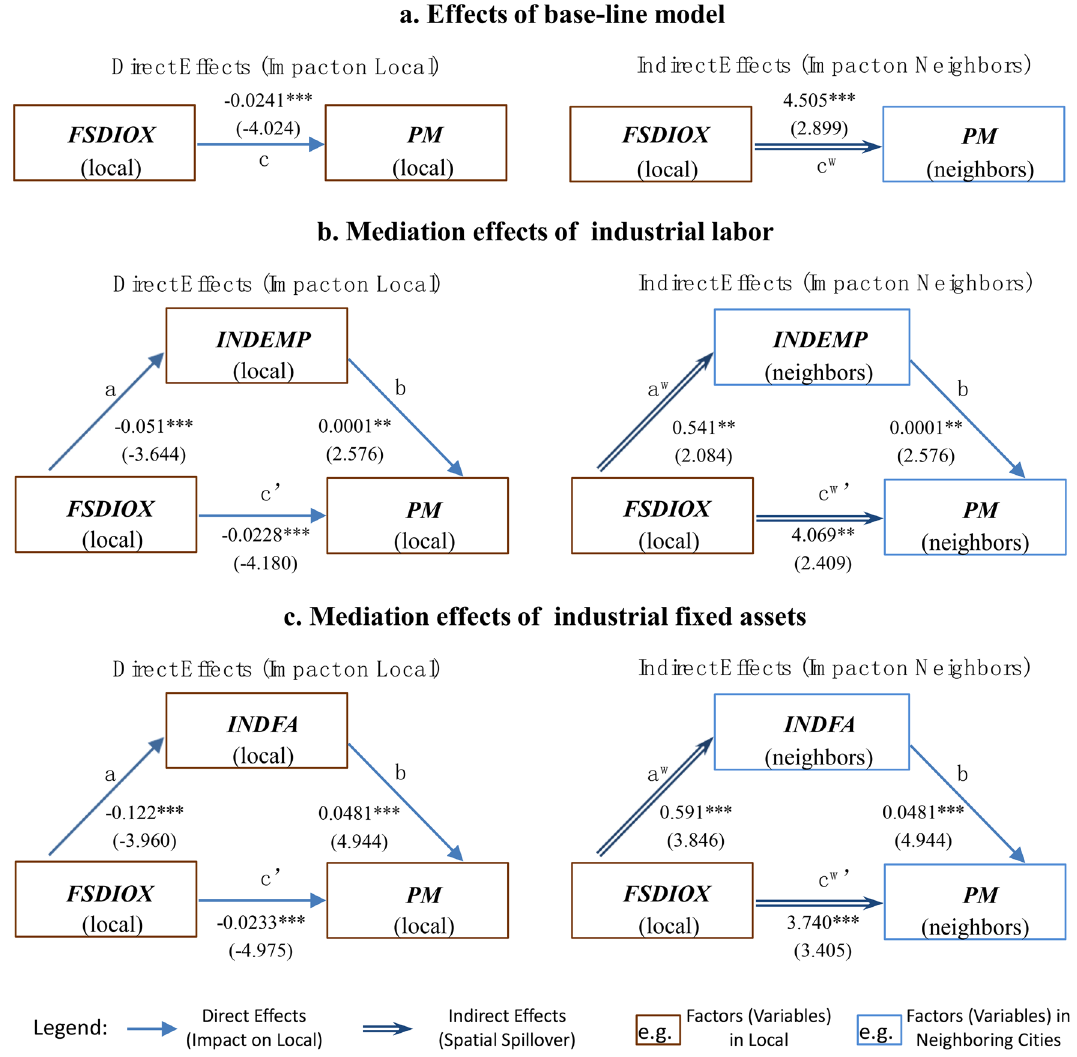
Figure 5. The mediation effects of industrial production factors. Note: The t-statistics are marked in parentheses. *, **, and *** denote significance at 10%, 5%, and 1% levels,